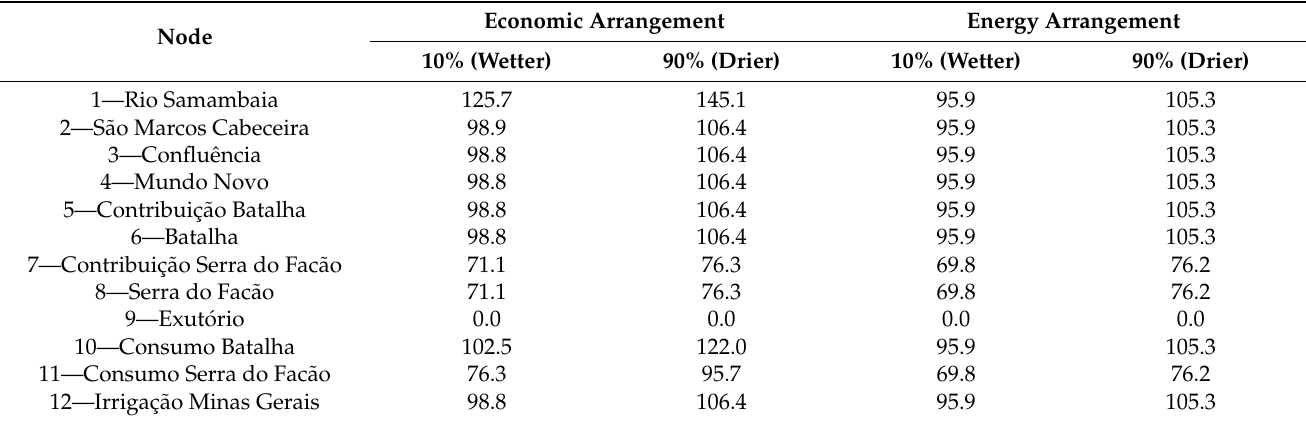
Table 5. Average marginal values.